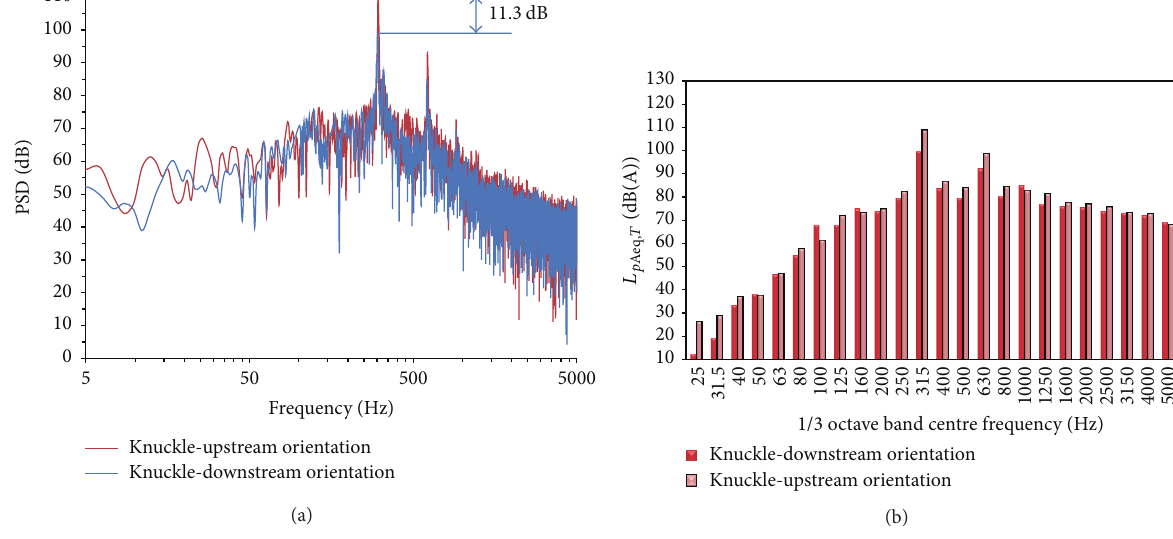
Figure 17: Spectral comparisons at b4: (a) PSDs and (b) 1/3 octave band centre frequencies.